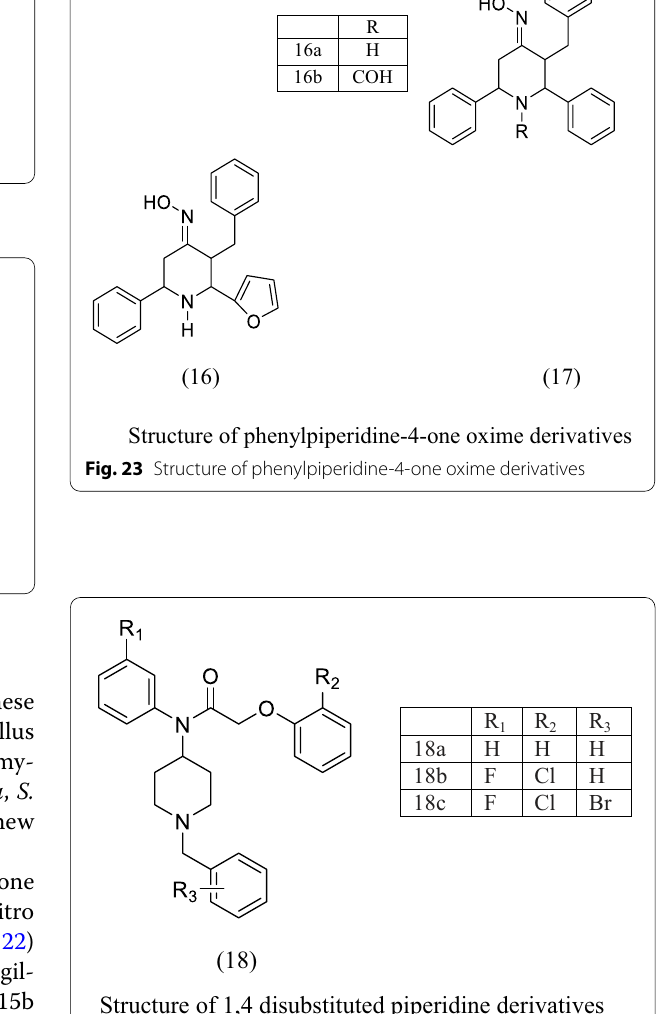
Fig. 24 Structure of 1,4 disubstituted piperidine